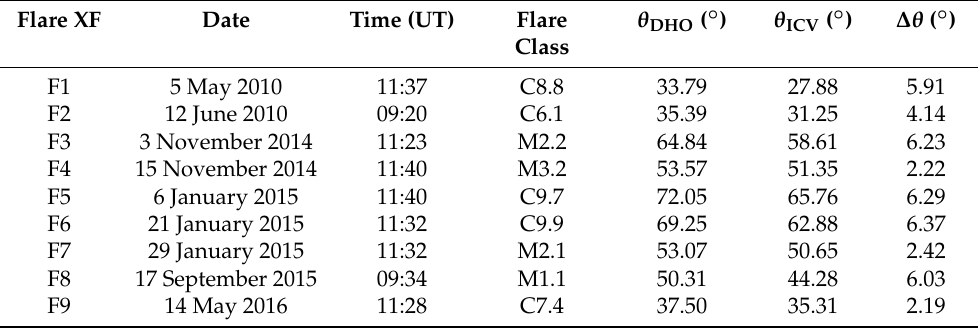
Table 1. Dates, times, and classes of the considered X-ray flares, and zenith angles θ DHO and θ ICV for the latitude/longitude points of the middle propagation paths DHO-BEL and ICV-BEL, respectively. Differences of these angles, ∆ θ , are given in the last column. The positions of the considered VLF signal mid-paths, and corresponding angles θ DHO , θ DHO and ∆ θ are calculated using tools given at https://www.gpsvisualizer.com/calculators and https://www.esrl.noaa.gov/gmd/grad/solcalc/ azel.html, respectively. Flare